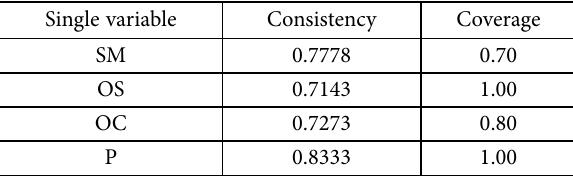
Table 6. Necessity analysis result of single condition